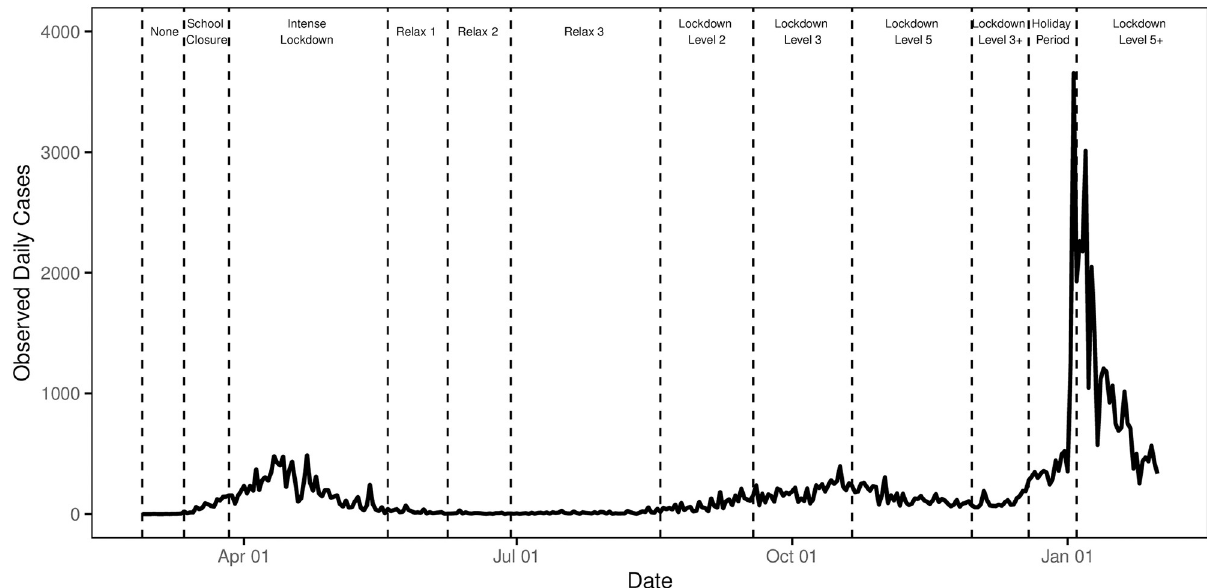
Fig 1. COVID–19 daily case incidence with corresponding lockdown levels in each period between February 2020 and January 2021. Descriptions of individual lockdown levels are presented in S1 Table in S1 File.